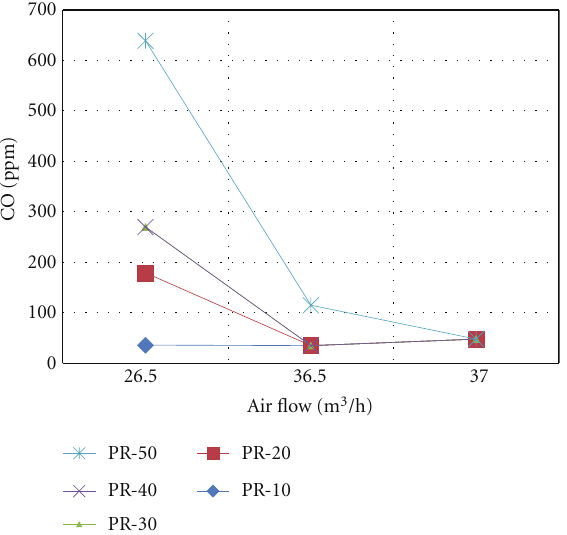
Figure 7: CO emissions depending on regulation